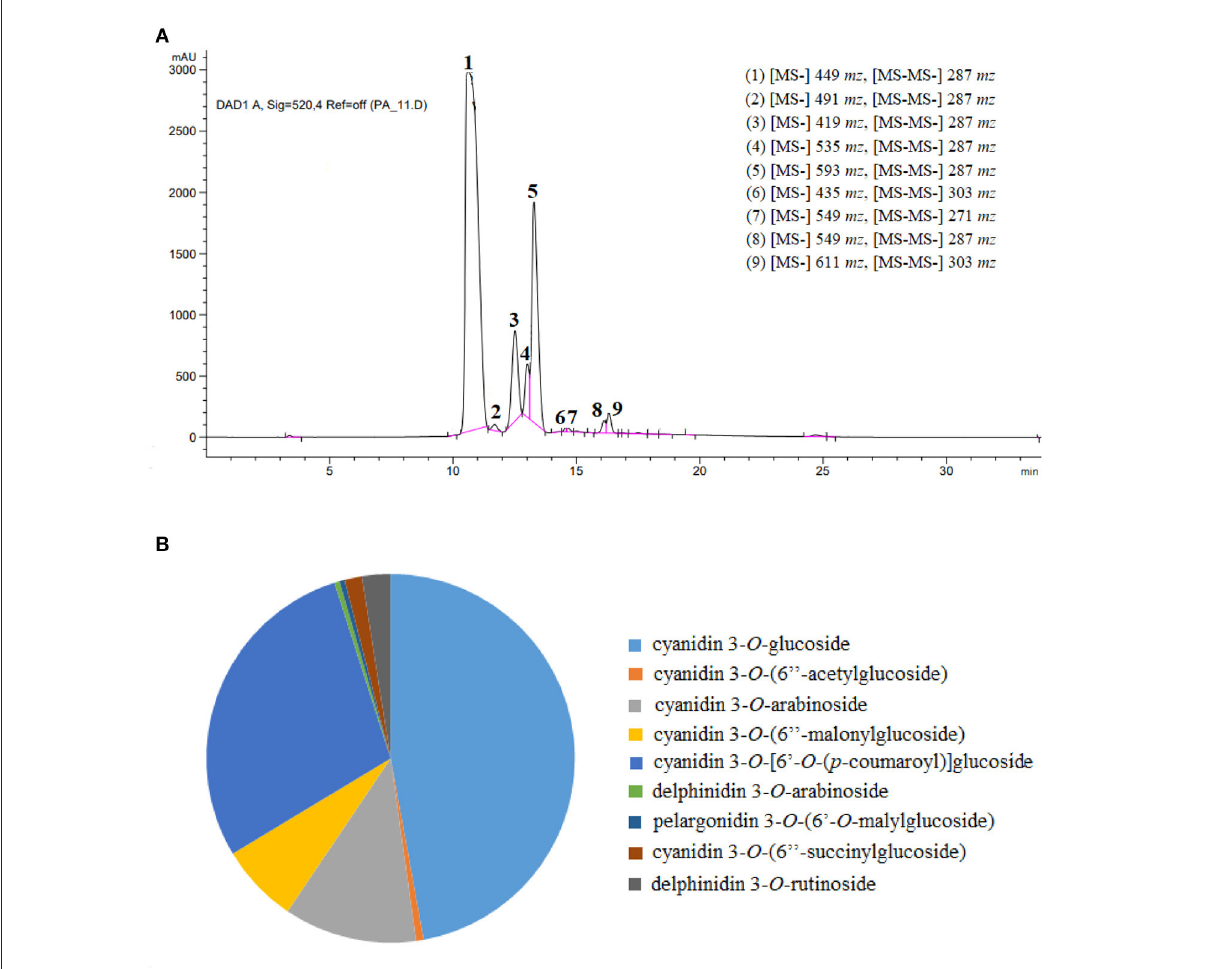
FIGURE4 Identification of anthocyanidin compounds in blackberry purified extracts. (A,B) Represented the high-performance liquid chromatograms with ion fragment information, and the proportional distribution of anthocyanin individuals,